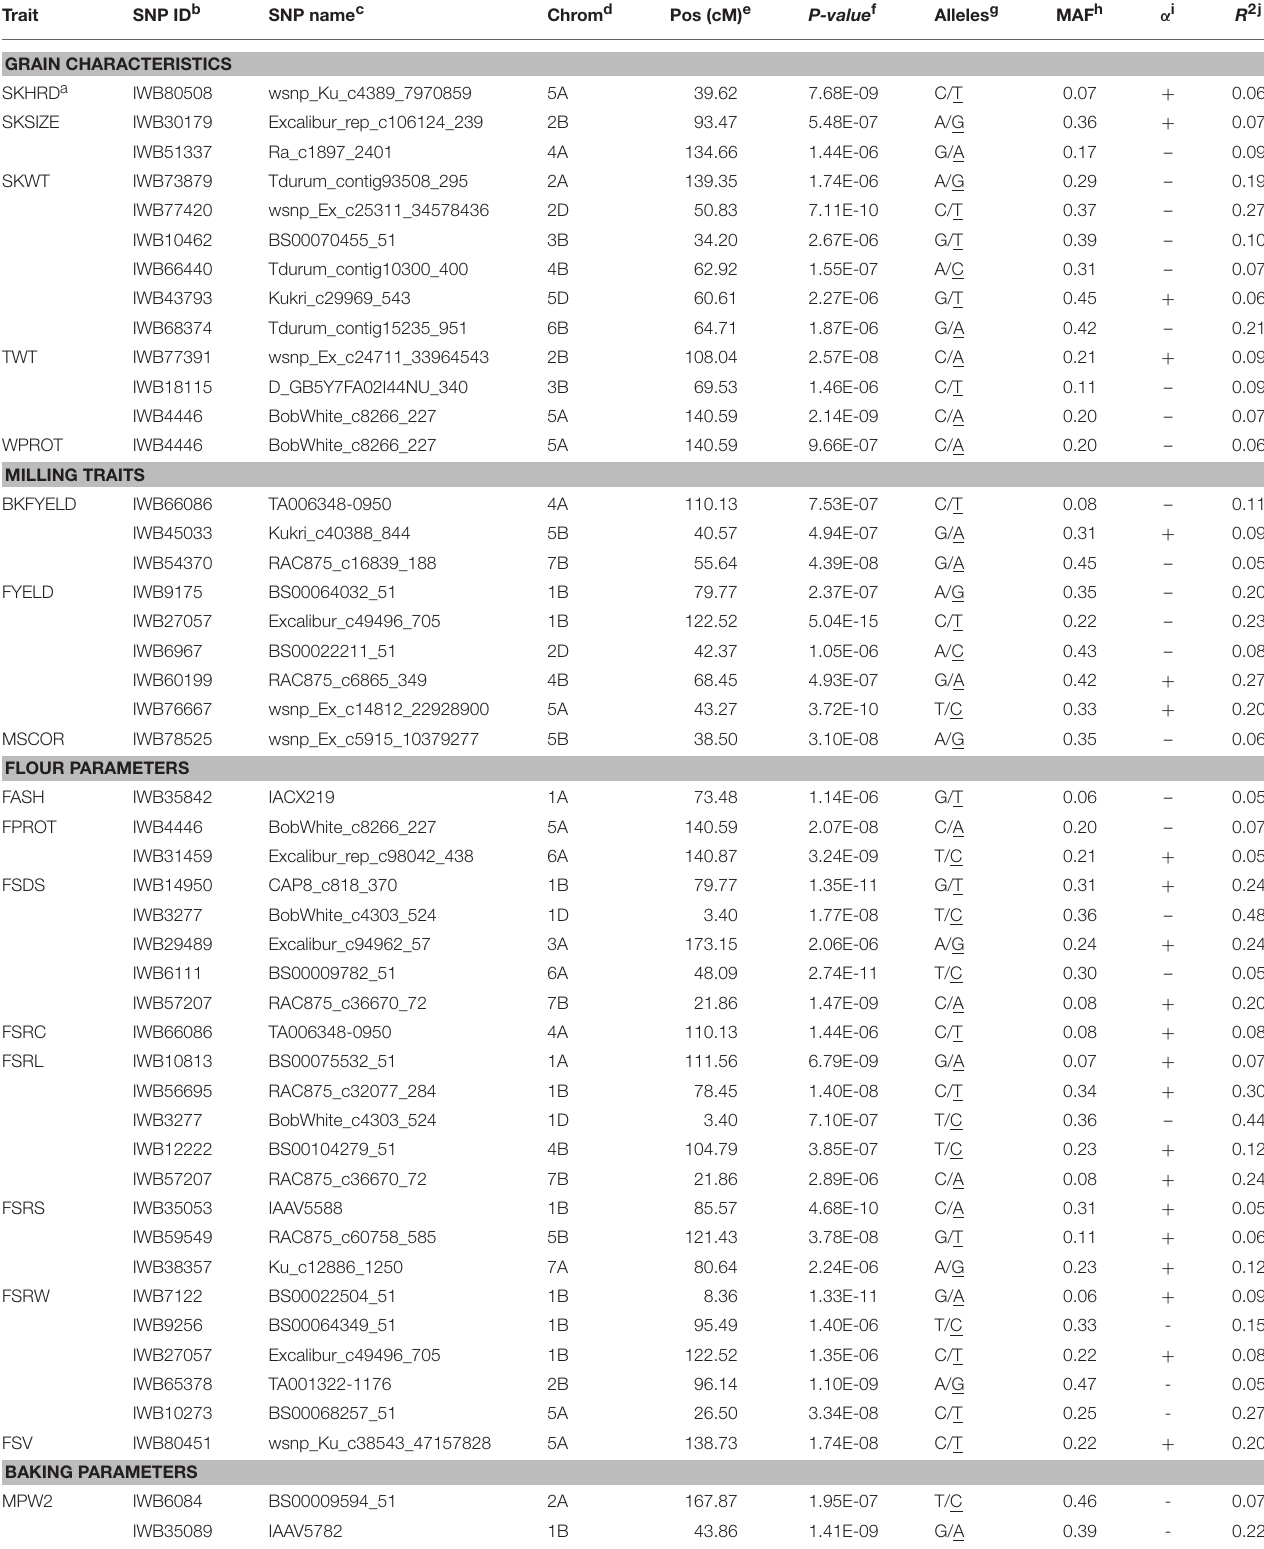
TABLE 2 | Markers associated with end-use quality traits in the Pacific Northwest soft white winter wheat diversity panel.